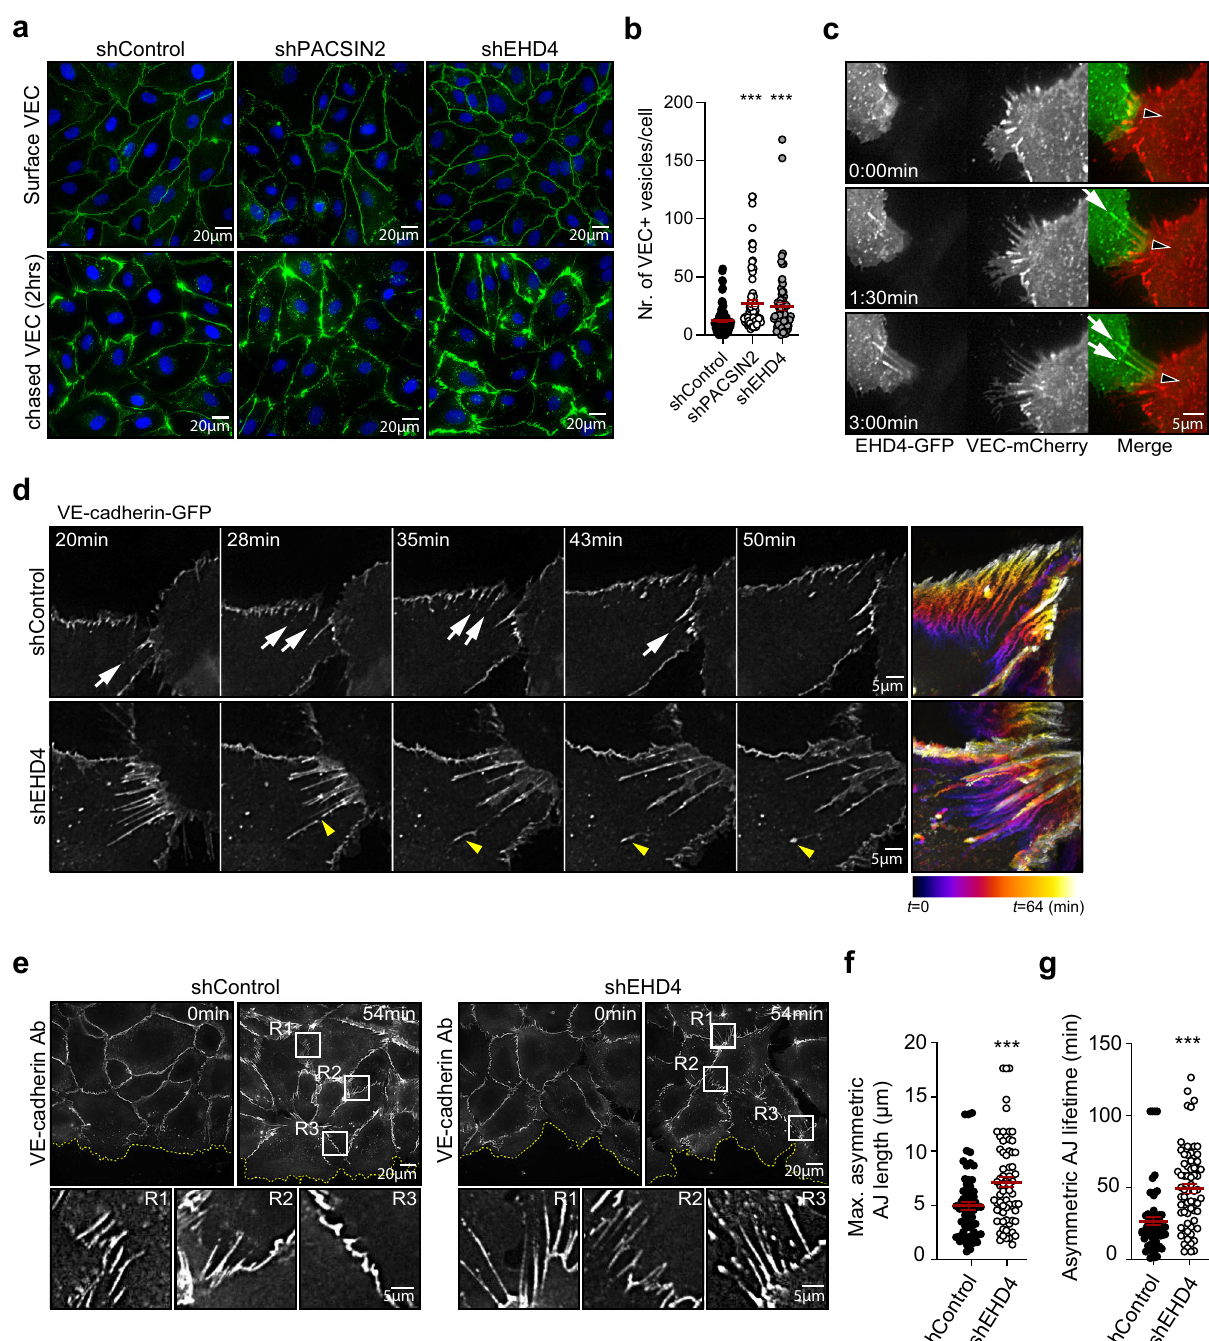
antibody and its corresponding secondary, retinas were blocked for 2h at RT with the Af fi niPure F(ab ′ )2 fragments Donkey anti-rabbit IgG (1/100, Cat# 711-006- 152) from Jackson ImmunoResearch. Retinas were washed three times in PBST and fi xed with 4% PFA at RT for 5 min. Next, retinas were washed with PBS and blocked with blocking buffer for 30 min at 4°C followed by incubation with anti-GOLPH4 antibody in blocking buffer overnight at 4°C. Finally, retinas were incubated with the corresponding secondary antibody in Pblec as described above.